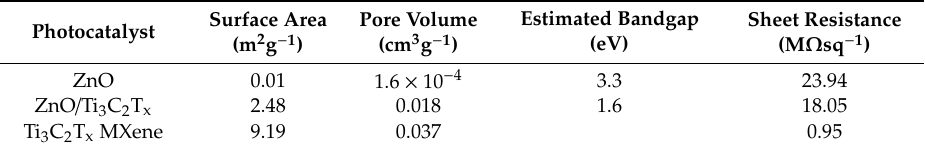
Table 1. Summary of major physical parameters for three di ff erent